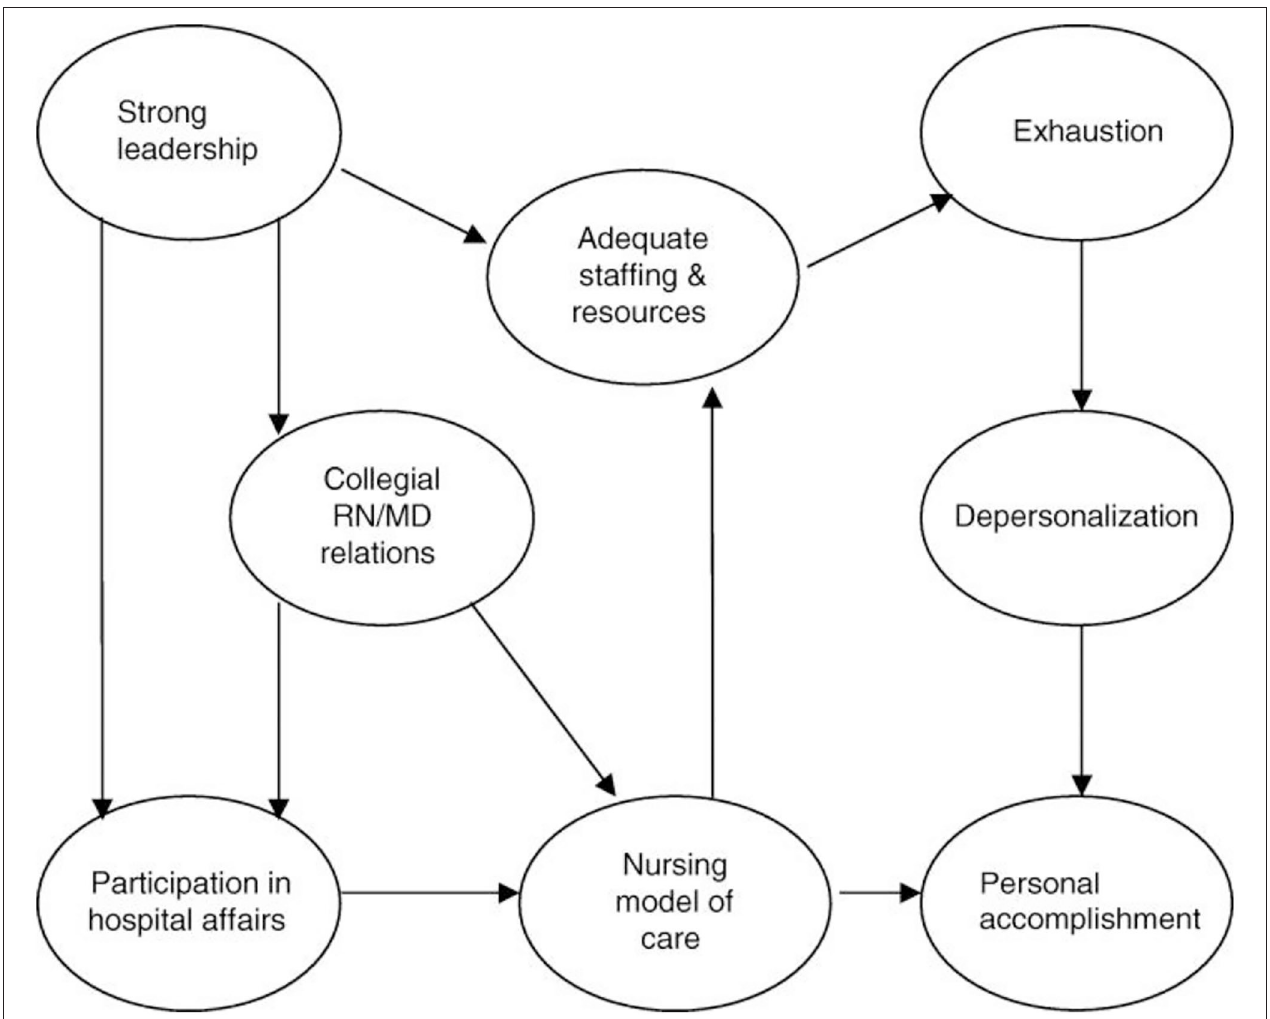
FIGURE 1 | The Nursing Work-Life Model. Source: Manojlovich and Laschinger